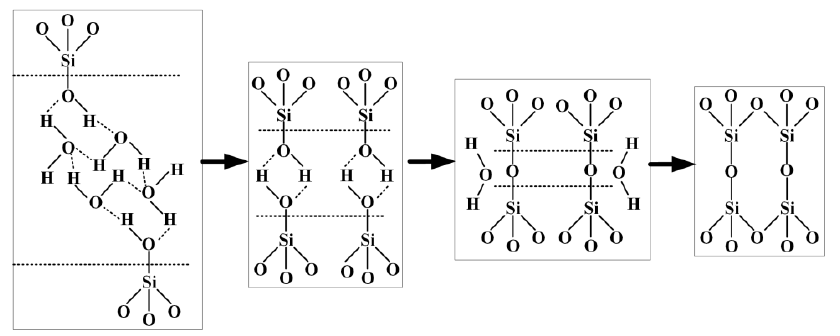
Figure 3. The principle of direct bonding.